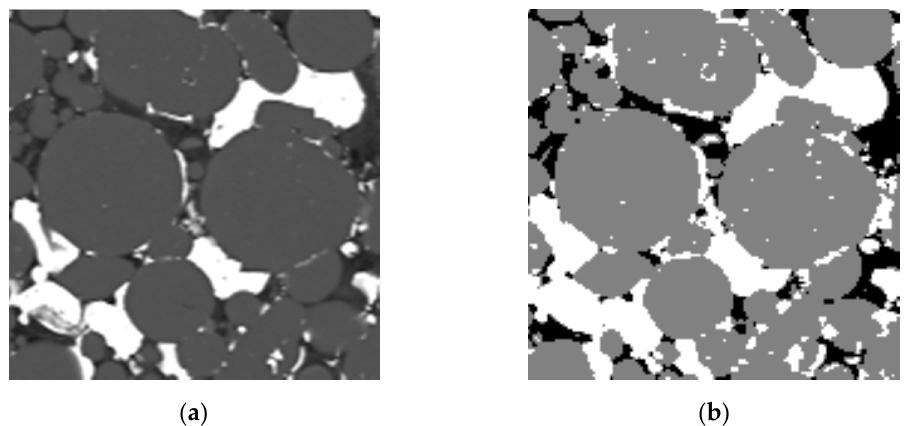
Figure 1. Area of Al-10vol%Sn microstructure prepared for the Lattice Monte-Carlo (LMC) method: ( a ) Original cropped image and ( b ) three-zone image after application of a multi-threshold. The side of the micrograph is 80.54 µm in length.